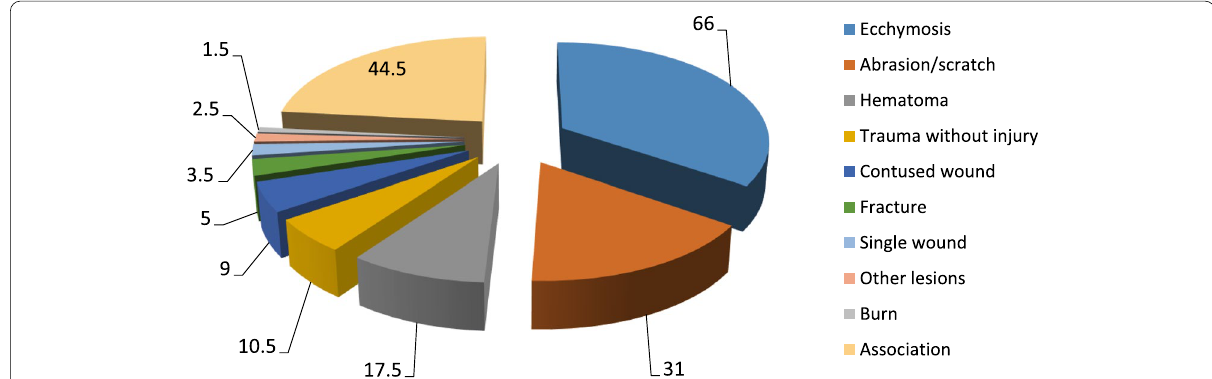
Fig. 1 The nature of the violent injuries found by the women examined. The physical consequences of the injuries sustained are mainly represented by first degree bruises (bruises) and the category of victims with multiple injuries (two or three post-traumatic injuries). Two injuries 82 victims. Three injuries 7 victims. (A single victim may have several types of =